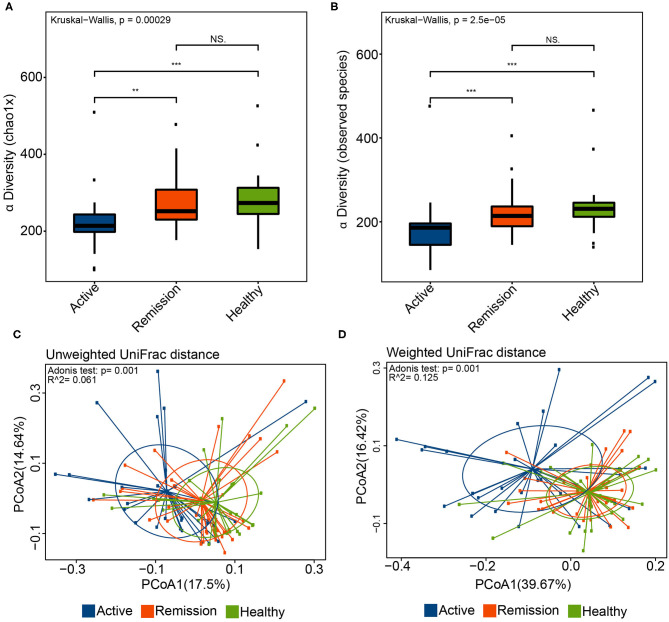
Alpha and Beta diversity in the oral microbiome of IBD patients and healthy controls. (A) Chao1 diversity index in the three sample groups. (B) Boxplot indicating the number of observed species in the three sample categories. (C) Principle coordinate analysis (PCoA) using the unweighted UniFrac distance and Adonis test. Blue color represents samples from active phase, orange indicates remission phase while green color indicates healthy samples. (D) PCoA using the weighted UniFrac distance and Adonis test. ** and *** correspond to P values < 0.01 and 0.001, respectively.